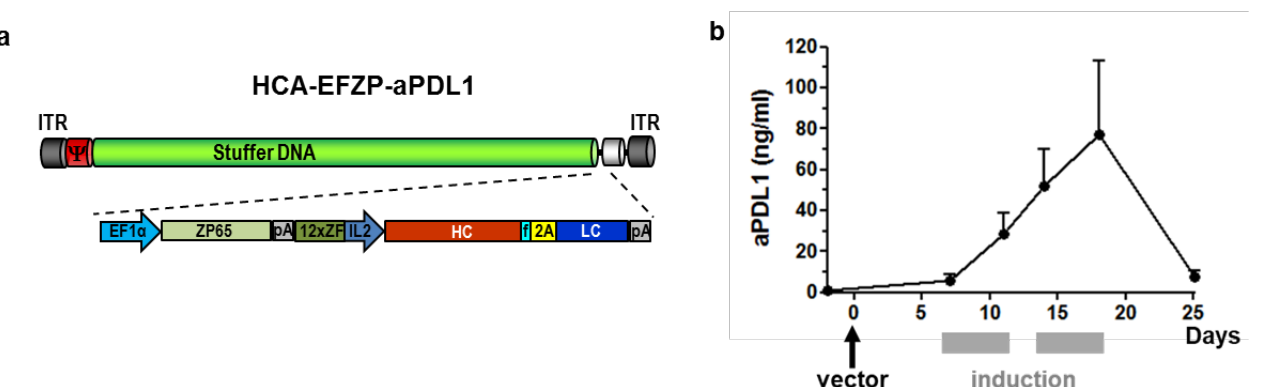
Figure 1. Characterization of the HCA-EFZP-aPDL1 vector. ( a ) Schematic representation of the vector genome. The vector backbone includes the inverted terminal repeats of adenovirus (ITR), the packaging signal ( ψ ) and stuffer DNA from human origin. The expression cassette comprises the inducible system for expression of the aPD-L1 coding sequence. 12xZF-IL2 is the inducible promoter based on a concatemer of ZF binding sites and the minimal interleukin-2 promoter. HC and LC are the heavy and light chains of IgG2a, linked by the 2A sequence from the foot and mouse disease virus and the furin recognition sequence (f). The ZP65 transactivator is expressed under the control of the elongation factor 1 α promoter. pA, poly-adenylation signal. ( b ) The vector was administered by i.v. injection in C57BL/6 mice (1 × 10 10 vg in 100 µ L, n = 3), and one week later, the expression of aPD-L1 was activated by i.p. injection of mifepristone on days 7–11 and 14–18 (gray rectangles). The concentration of aPD-L1 in serum was quantified by ELISA and expressed as average ng/mL ± SEM.